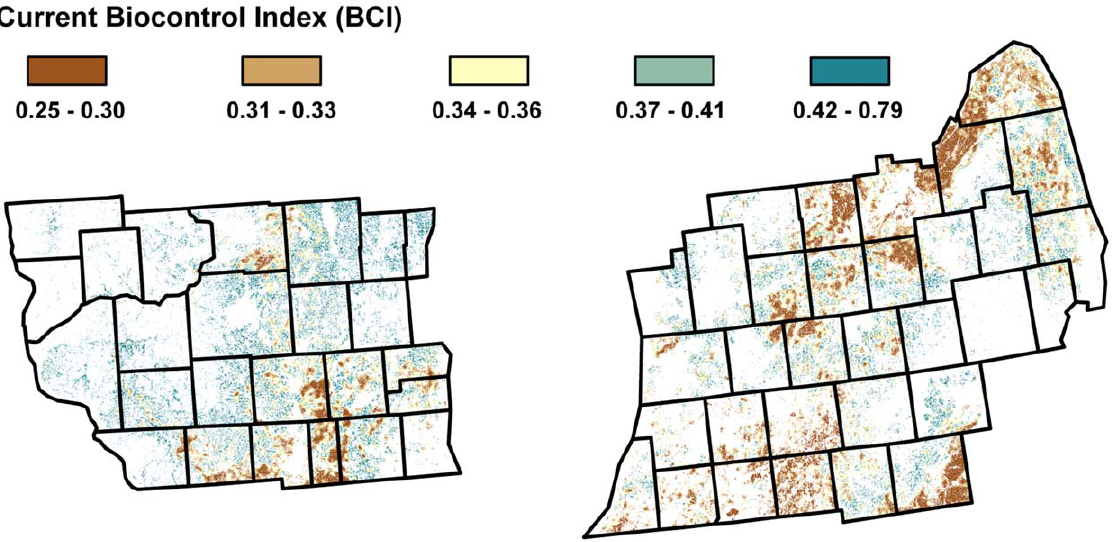
Figure 3. Projected biocontrol index. Biocontrol index from Eq. 1 for cropland pixels across the study region given the current landscape configuration. White pixels represent non-croplands (e.g. forest, urban